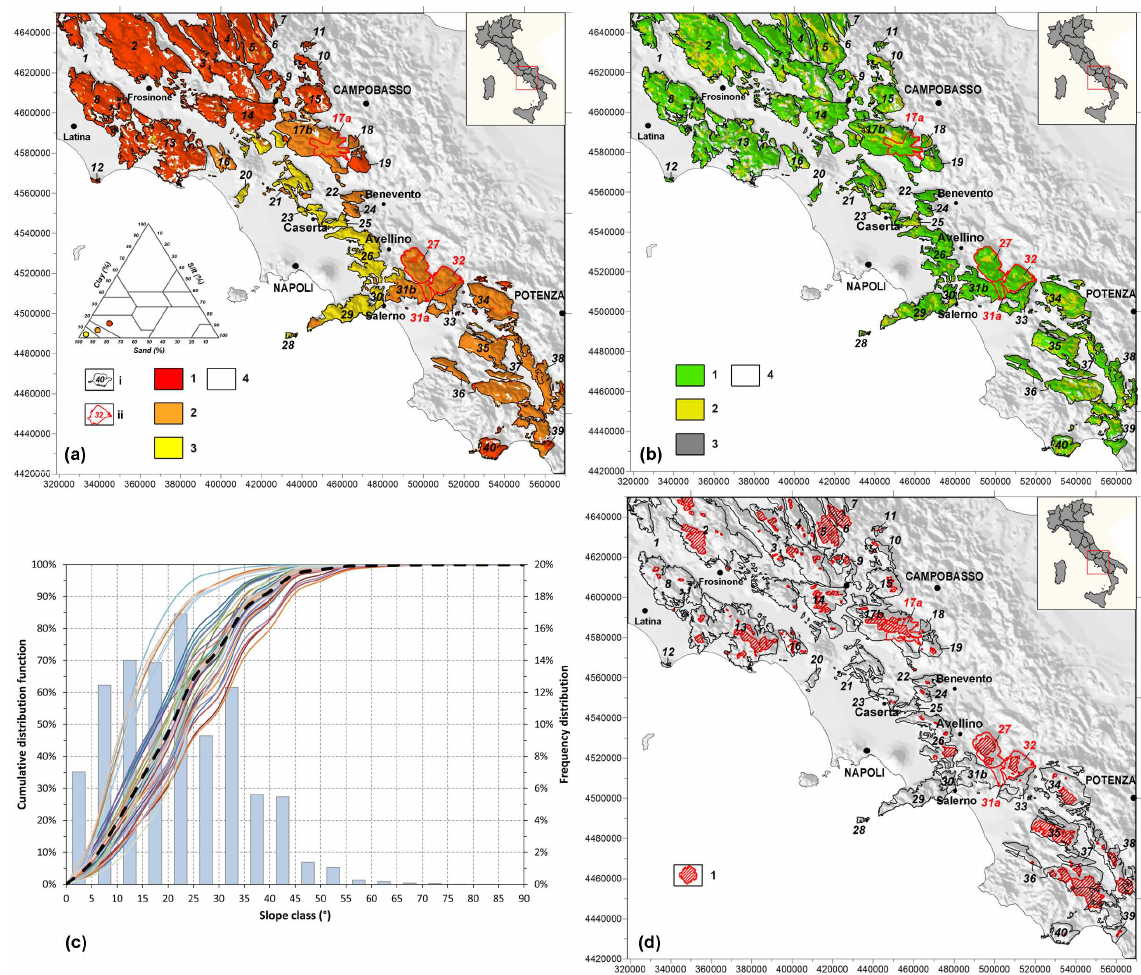
Fig. 3. (a) Soil texture map. Common symbols: (i) hydrogeological boundary and identification number of the karst aquifers; (ii) hydrogeo- logical boundary and identification number of the sample karst aquifers. Key to symbols: (1) sandy loam soil; (2) loamy sand soil; (3) sandy soil; (4) area with no soil. (b) Land use map. Key to symbols: (1) woodland; (2) meadowland; (3) urban area; (4) no vegetation area. (c) Fre- quency analysis of the slope angle distribution for the karst aquifers. Key to symbol: (coloured line) Cumulative distribution of single karst aquifer; (dashed black line) Mean cumulative distribution; (histogram) Mean frequency distribution. (d) Summit plateau areas and endorheic watersheds map. Key to symbol: (1) limits of endorheic